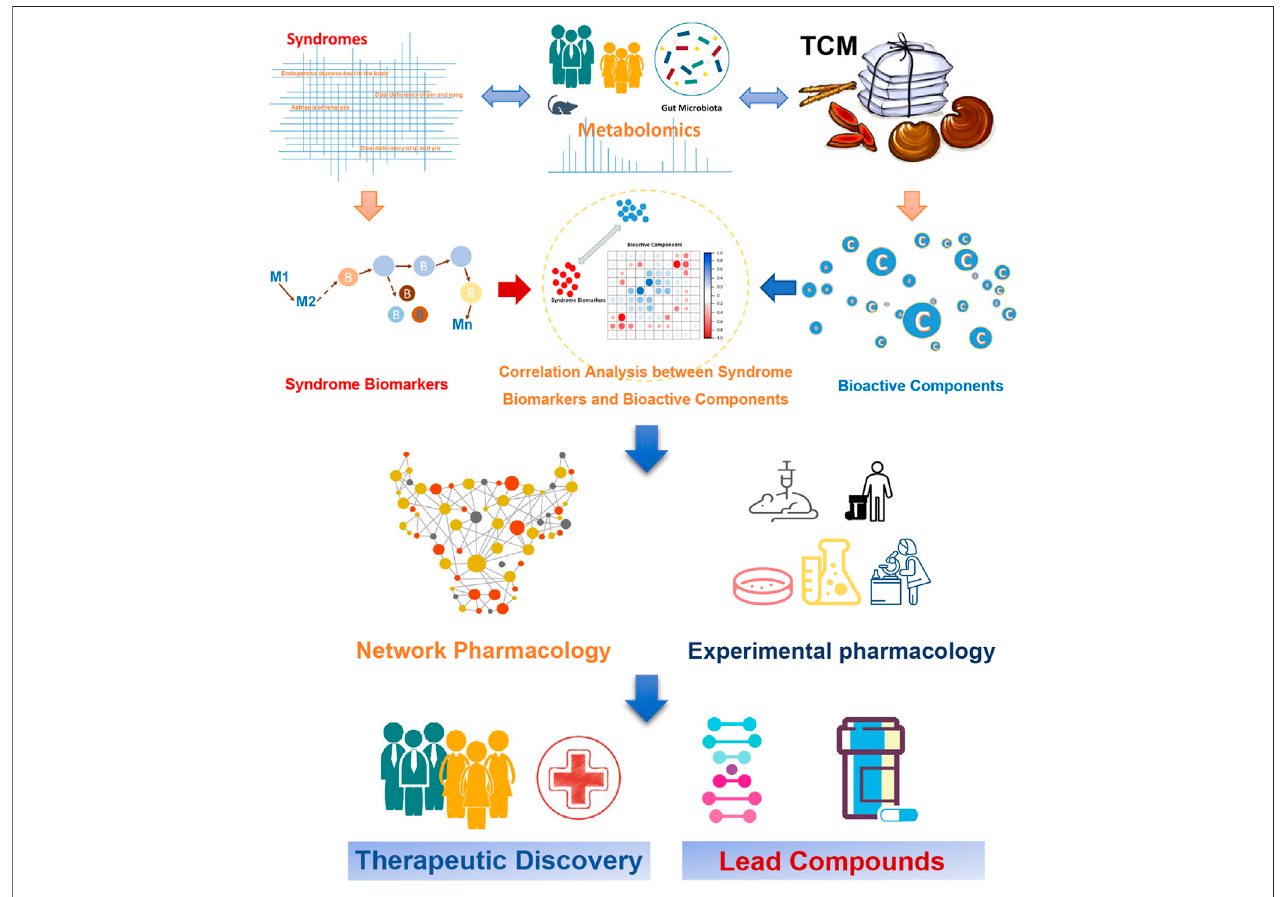
FIGURE 3 | Application of metabolomics to assess the ef fi cacy of TCM for treating T2DM, for the purpose of developing new anti-diabetes therapeutics.